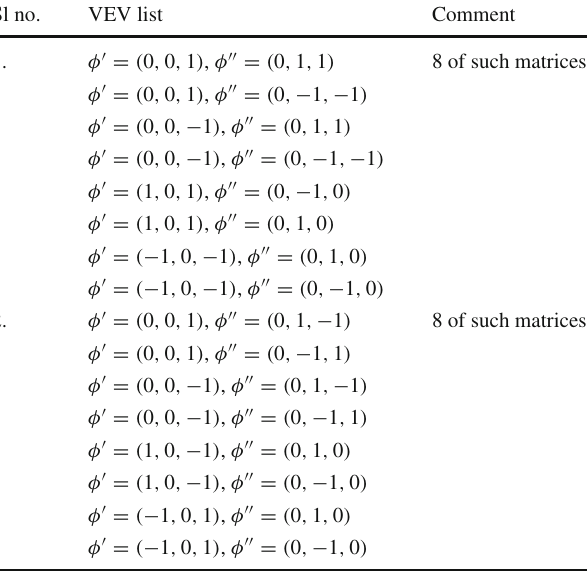
Table 21 VEV alignment of triplet flavon fields φ (cid:3) , φ (cid:3)(cid:3) for texture 2 zero symmetric case, that give rise to same complex constraints Sl no.